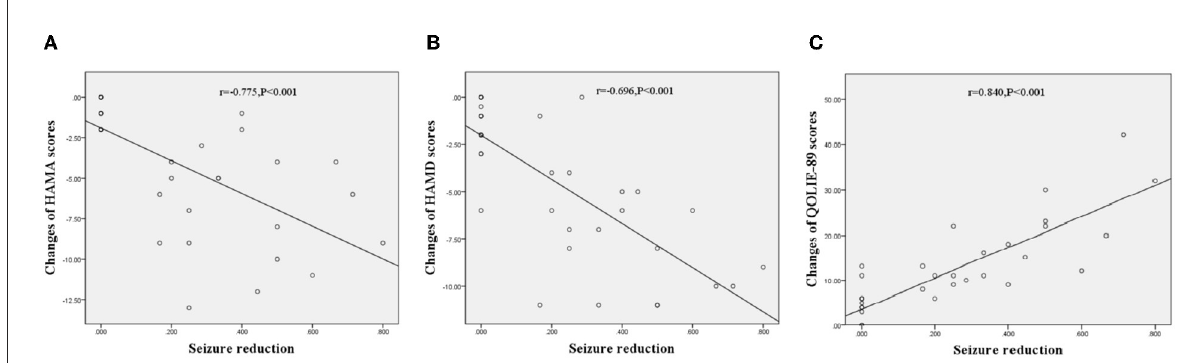
FIGURE3 Correlations between changes of neuropsychiatric performances treated with probiotics and seizure reduction in TLE patients. (A) Correlations between changes of HAMA scores and seizure reduction, r = − 0.775 , p < 0.001. (B) Correlations between changes of HAMD scores and seizure reduction, r = − 0.696 , p < 0.001. (C) Correlations between changes of QOLIE scores and seizure reduction, r = 0.840, p <